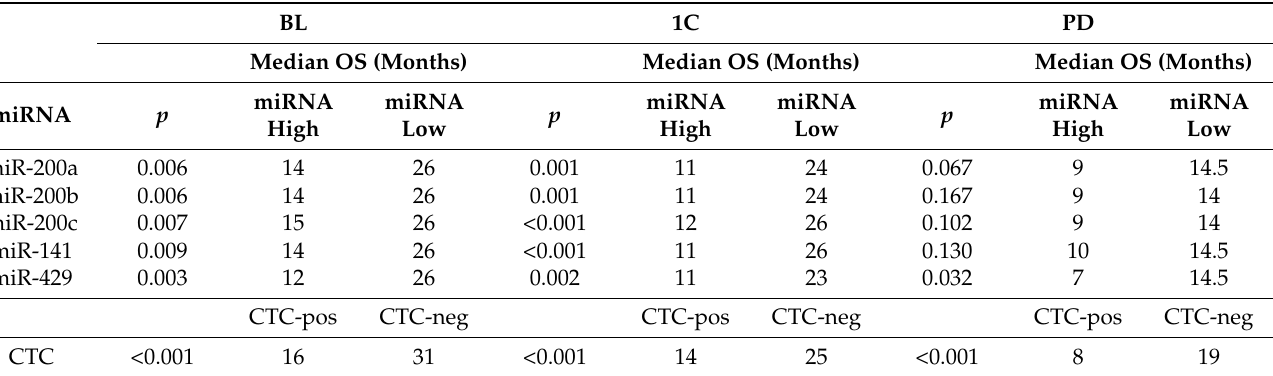
Table 4. Log-rank test comparing OS distribution among levels of miRNA expression and CTC